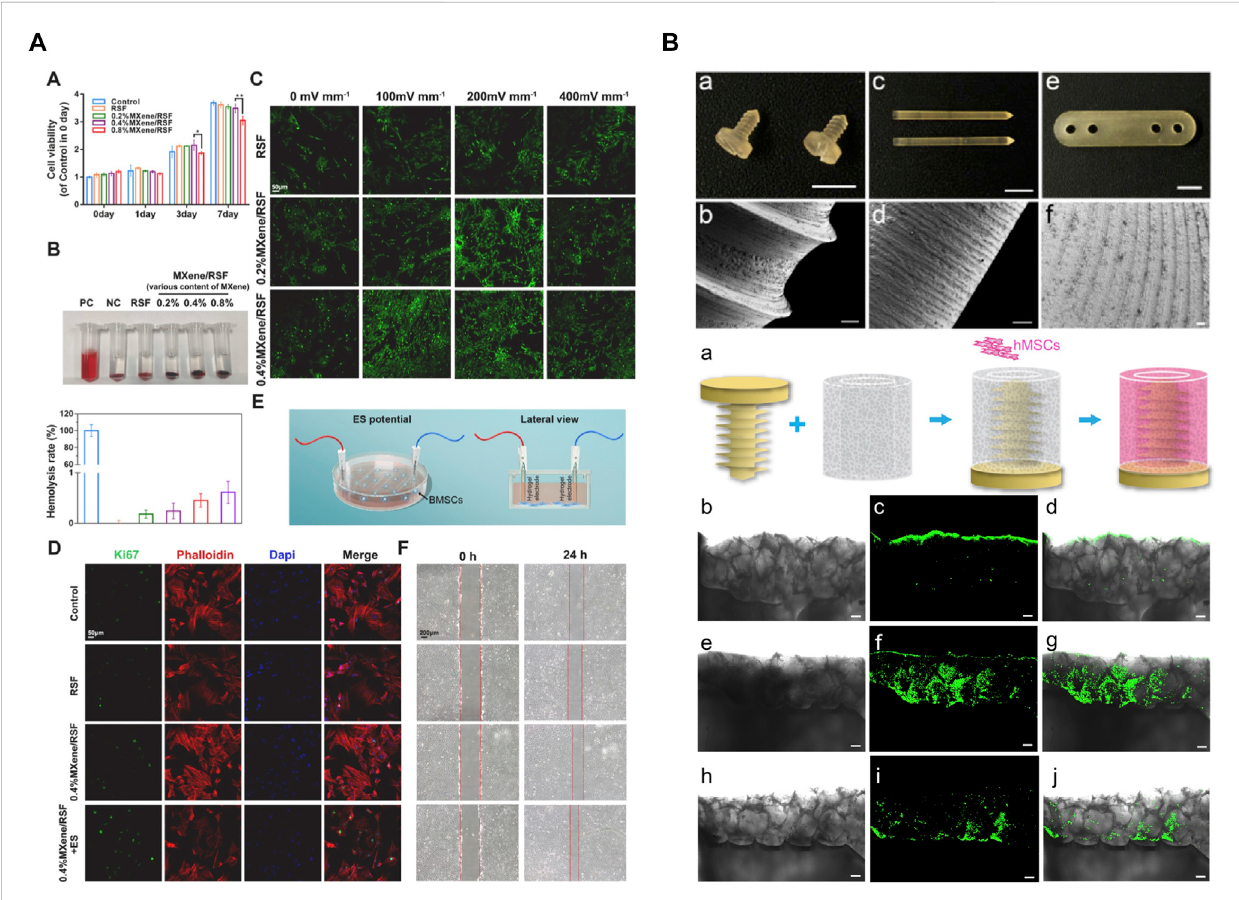
FIGURE 8 Silk hydrogels and devices for bone tissue regeneration. (A) SF-MXene hydrogel re-established the electrical microenvironment and promoted directosteogenesis. (B) Silk-basedorthopedicdeviceswithosteoinductivefunctionality.Adaptedwithpermissionfromref(Lietal.,2016;Huetal.,2023). Copyright 2016 Elsevier, 2023